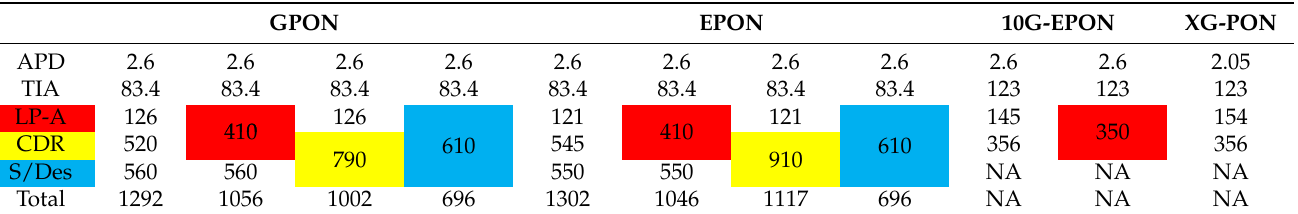
Table 6. Power consumption [mW] of ONU/ONT without—with component integration 1